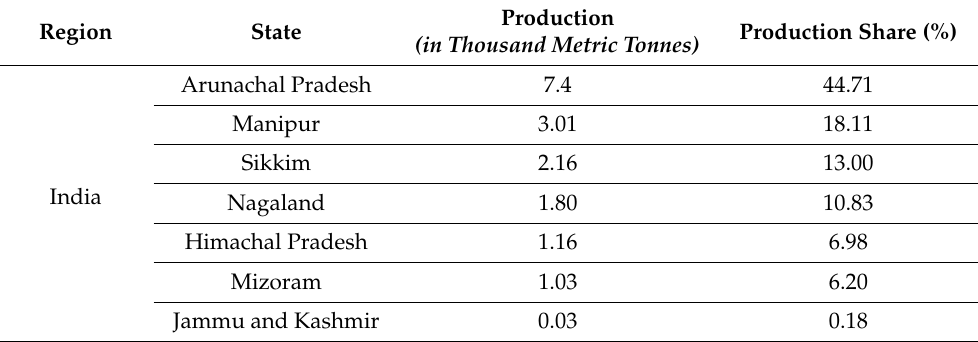
Table 1. Top kiwi fruit-producing countries in 2020 (Source: Statista). Production Region Countries (in Thousand Metric Tonnes) China, mainland 2230.01 New Zealand 624.94 World 521.53 307.44 289.61 Table 2. Top kiwi fruit-producing states in 2021–2022 (Source: APEDA). Production Region State Production Share (in Thousand Metric Tonnes)